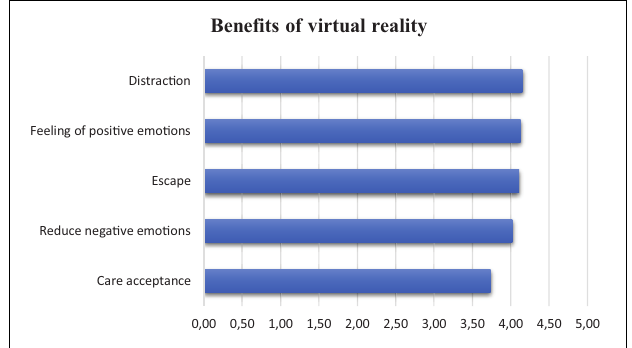
FIGURE 1 | Benefits of virtual